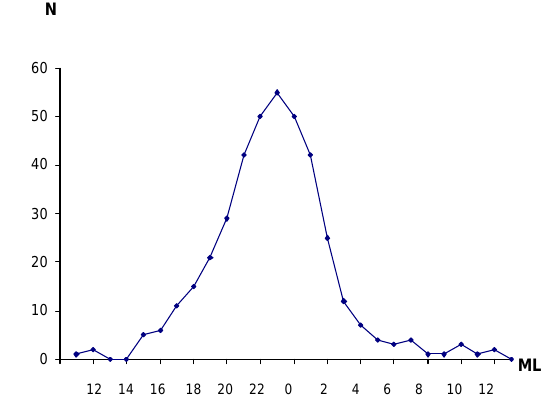
Fig. 8. Daily variation of auroral occurrence at Spitsbergen. Figure 8. Daily variation of auroral occurrence at Spitsbergen.